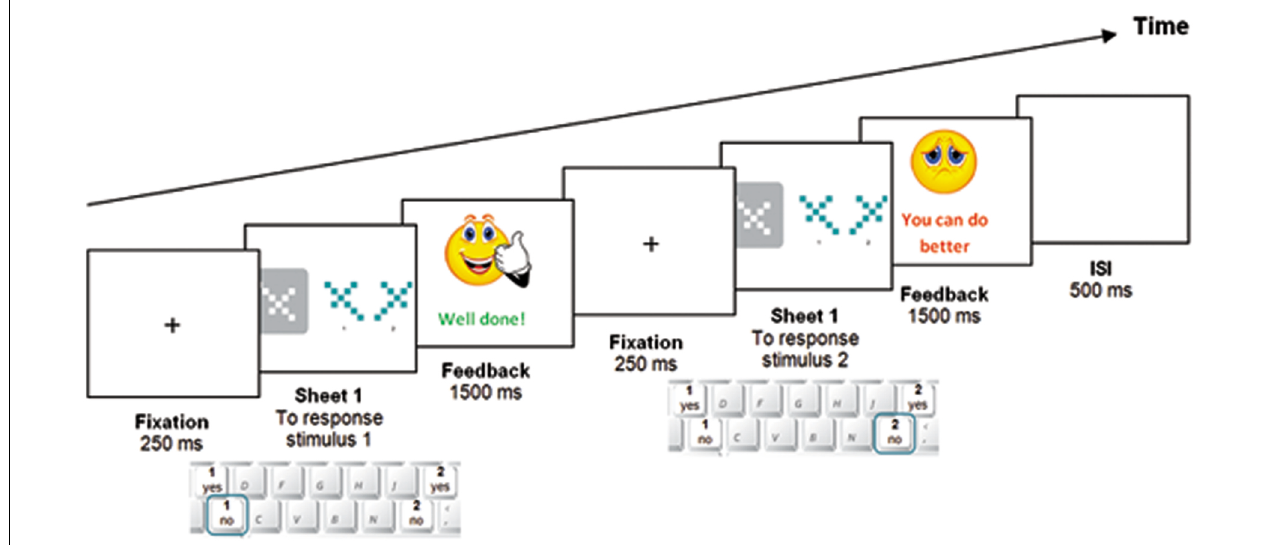
FIGURE 2 | Example of the temporal sequence of a MRTP